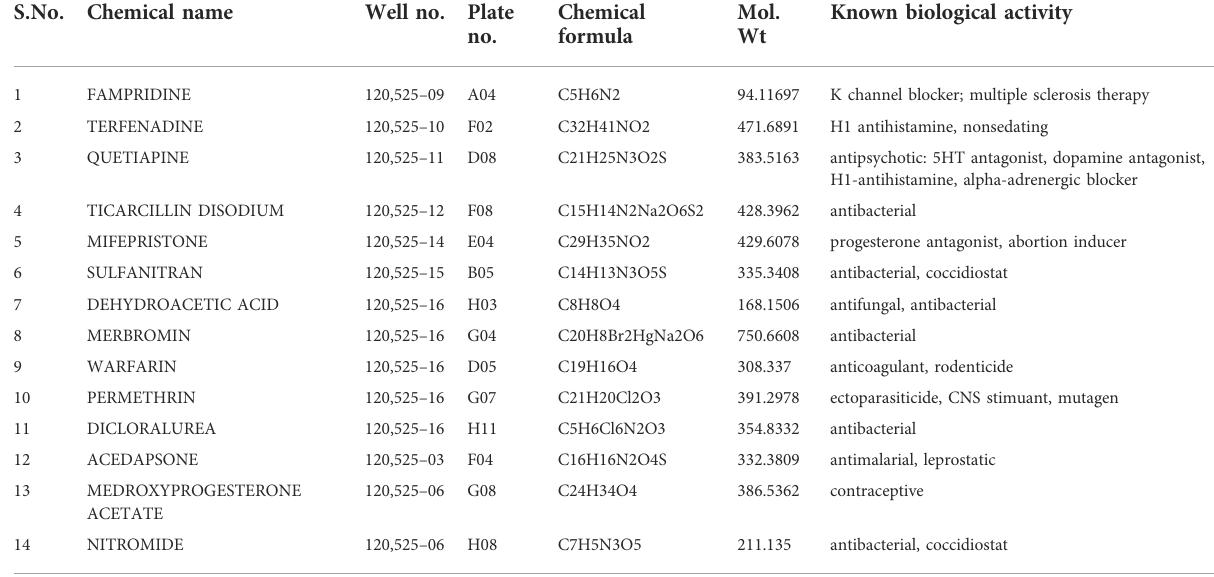
TABLE 2 List of 14 compounds modulating the regeneration of M-cell in Tg62A larvae: The table includes the compound position, chemical formula, molecular weight, and biological activity along with their effective concentration that down-regulate the M-cell regeneration (Gray shading indicates compounds at 100 µM and yellow one at 25 µM).